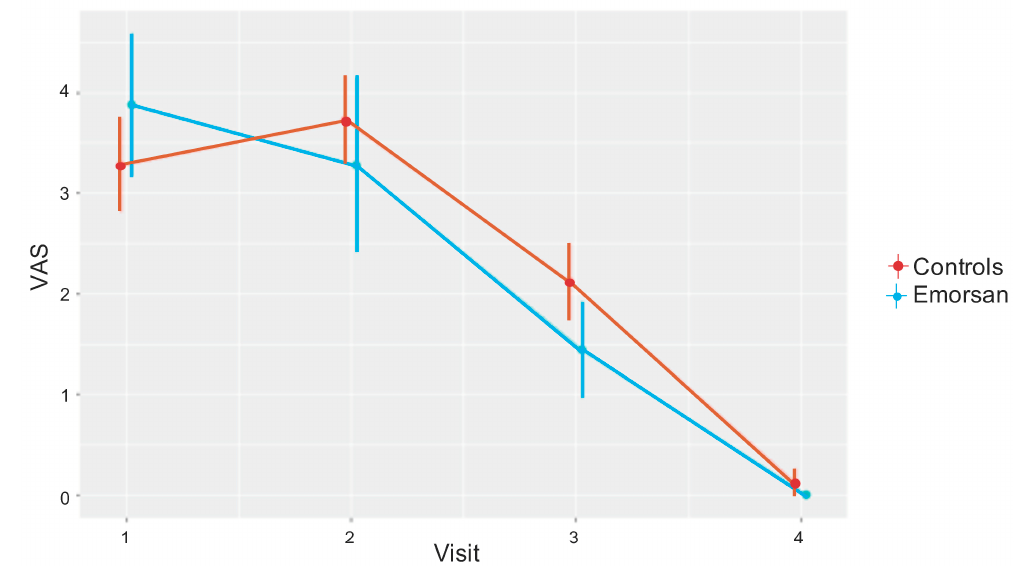
Figure 1. Visual analogue scale (VAS) mean scores in the two groups at each follow up visit. Table 2. Restricted maximum likelihood mixed model of the visual analogue scale (VAS) scores (between groups). ∆ VAS score Coe ffi cient p -Value 95% CI Lower Upper Emorsan ® Gel –0.09 –0.96 0.79 0.845 Age 0.01 –0.04 0.51 0.779 Gender 0.71 –0.81 0.95 0.874 CI: confidence interval.